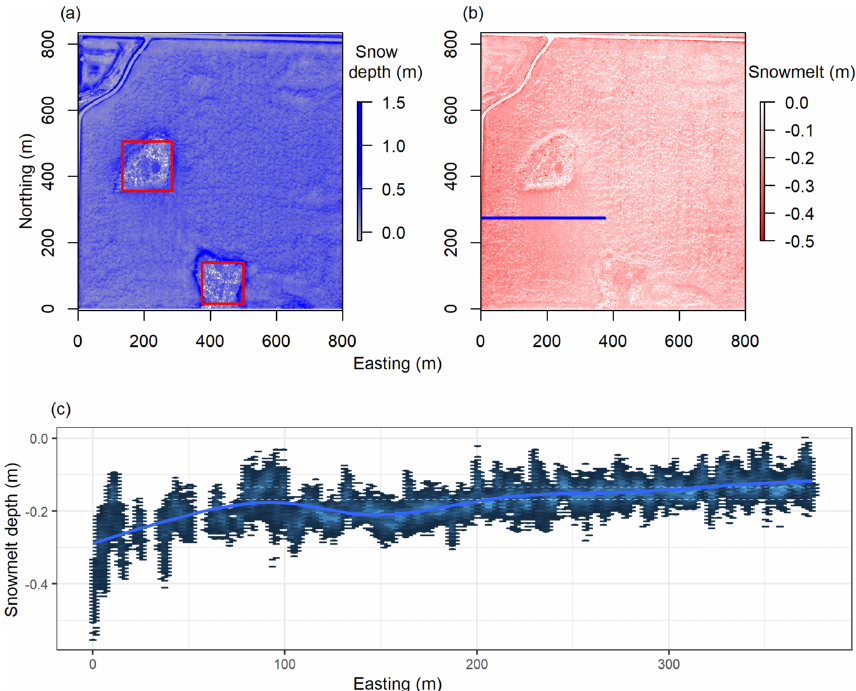
Figure 11. Peak snow depth at the Rosthern site from the UAV-lidar scan on 13 March 2019 (a) and snow melt depth difference from the UAV-lidar scans on 18 and 22 March 2019 (b) . Snow depth change (c) over a transect (blue line in b ) are plotted with a hex plot (to show variability) and smoothed line (to show mean change). Red polygons in (a) highlight wetland